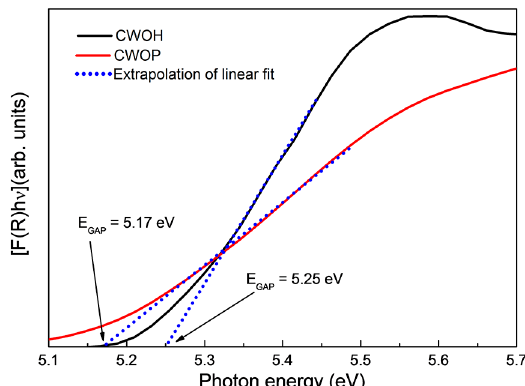
) calculated by the method g powders 4